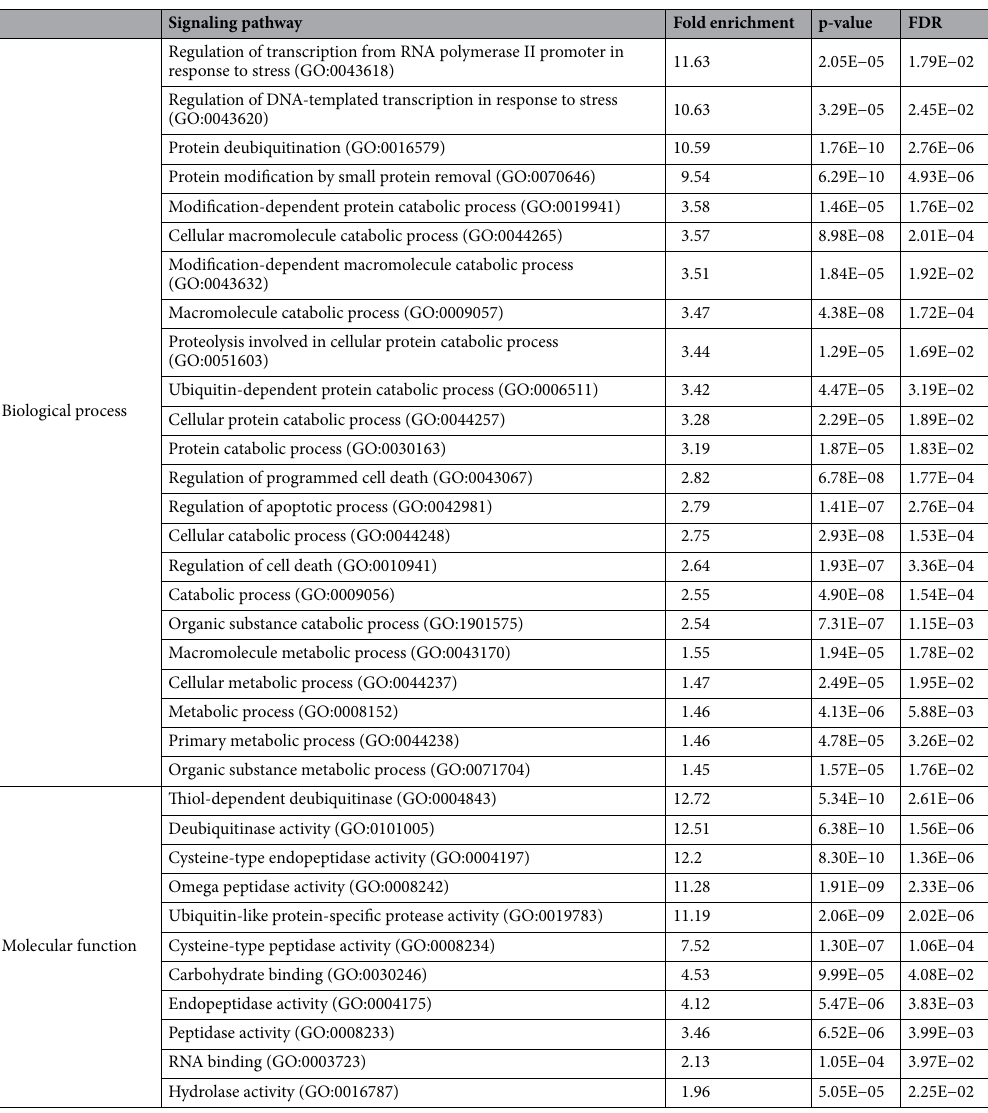
Table 2. Enrichment analysis for genes significantly upregulated in CD14++ monocytes of loPE vs control groups performed in